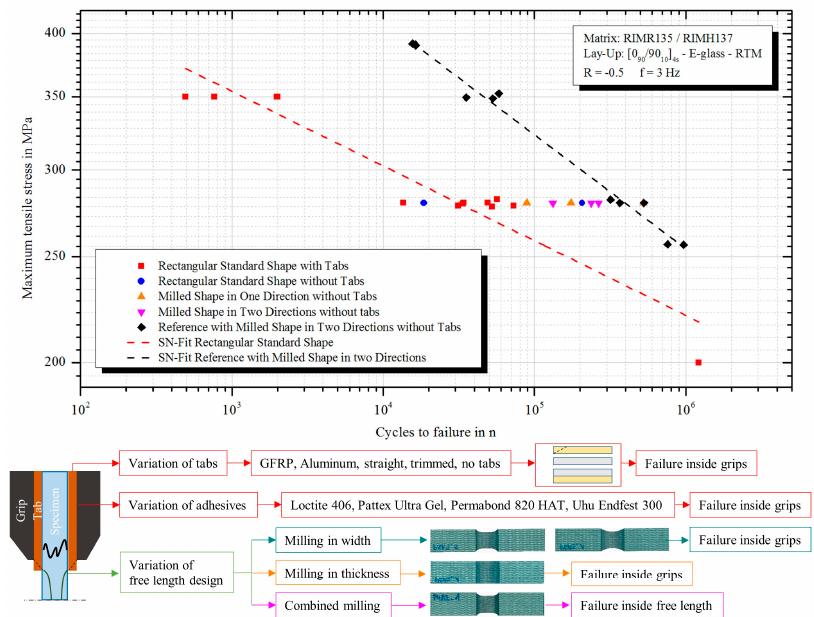
Figure 1. Results of the fatigue lifetime investigations concerning the tab area and the free specimen length. Invalid failure inside the grips occurred for all samples without a modified design. An overview of the tested variations is given in the lower part. GFRP—glass fibre reinforced polymer.